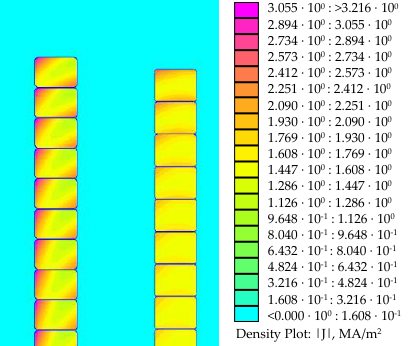
Figure 18. Current density of inductor in filter 3 (cylinder 1: 189 A; cylinder 2: 227 A; t = 293.5 s).